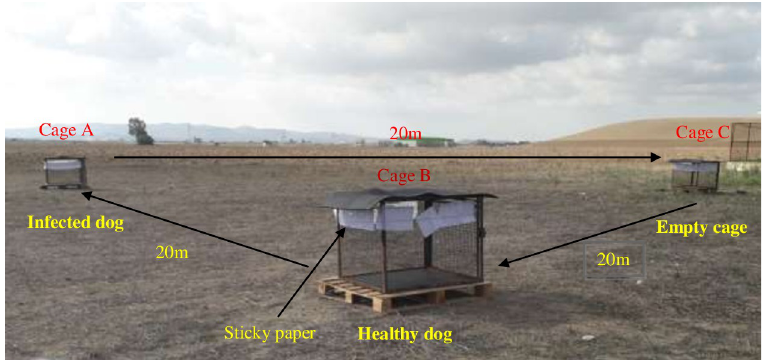
Fig 2. Host attractiveness experiment in the